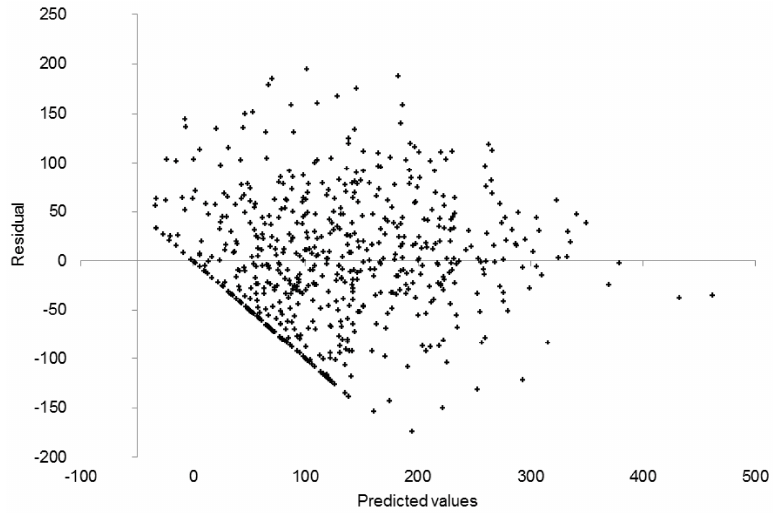
Figure 9. The residuals plotted against the predicted values.